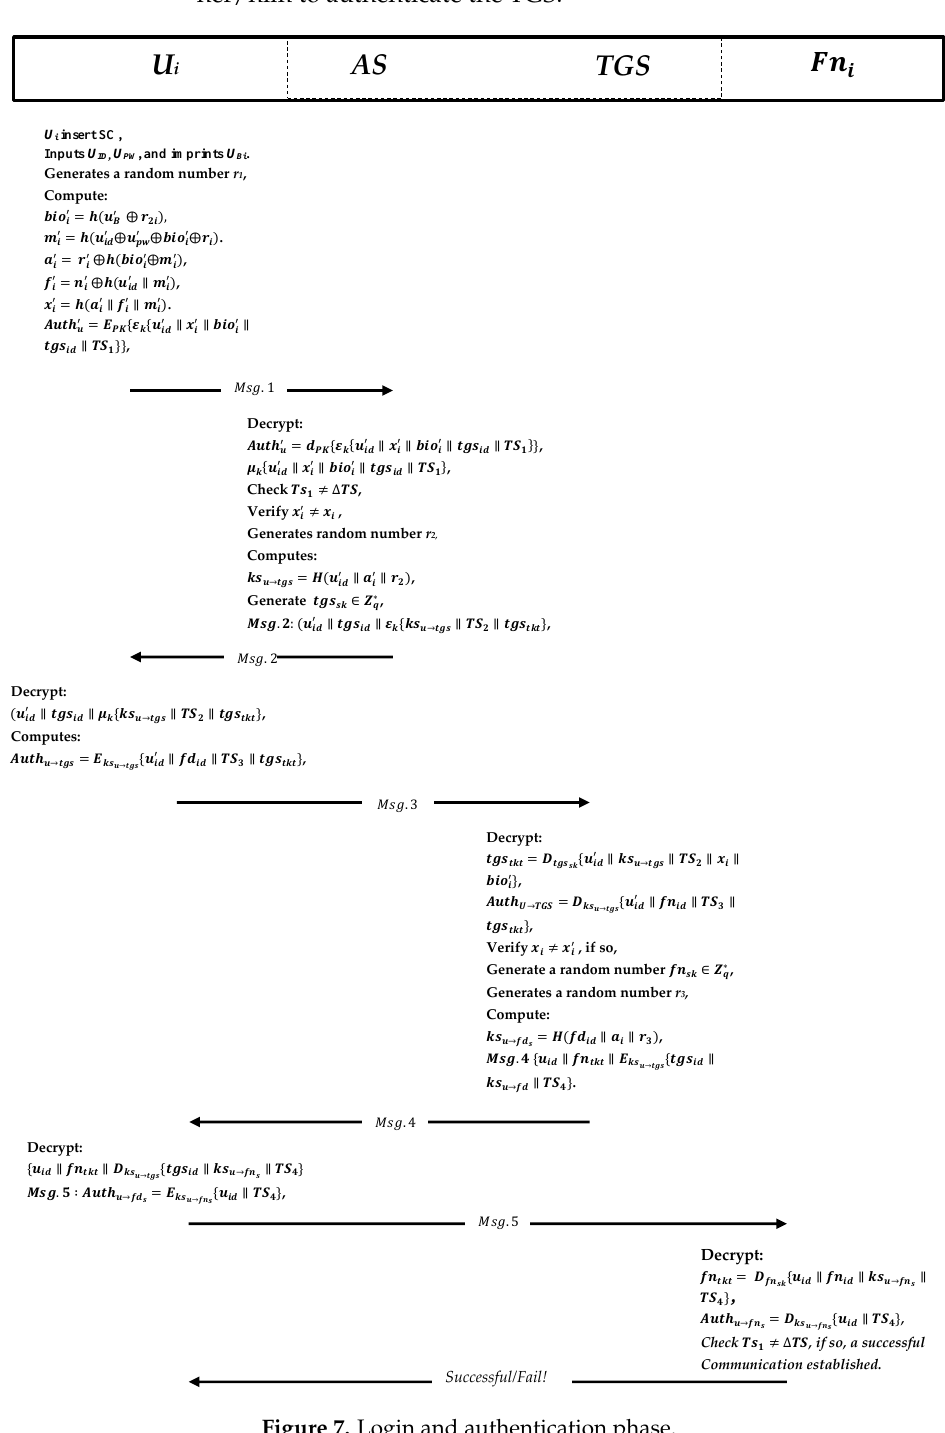
Figure 7. Login and authentication